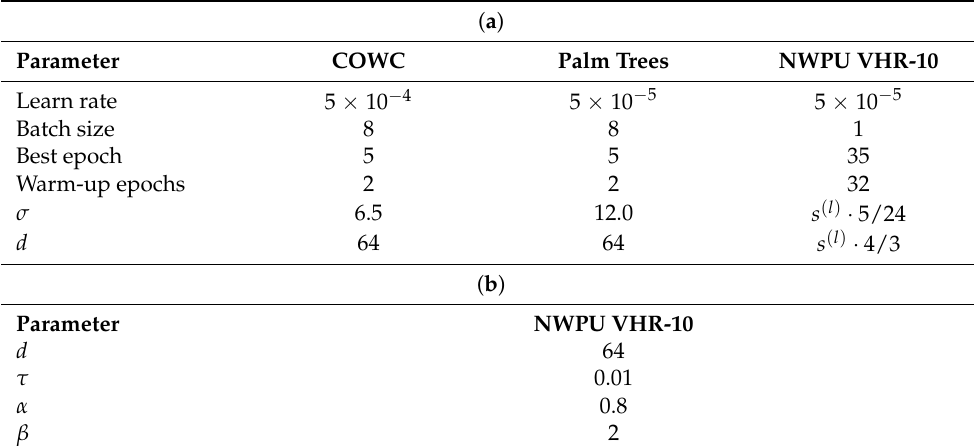
Table A2. Best hyperparameters for our label refinement techniques: ( a ) co-correction; ( b ) box size estimation (Algorithm